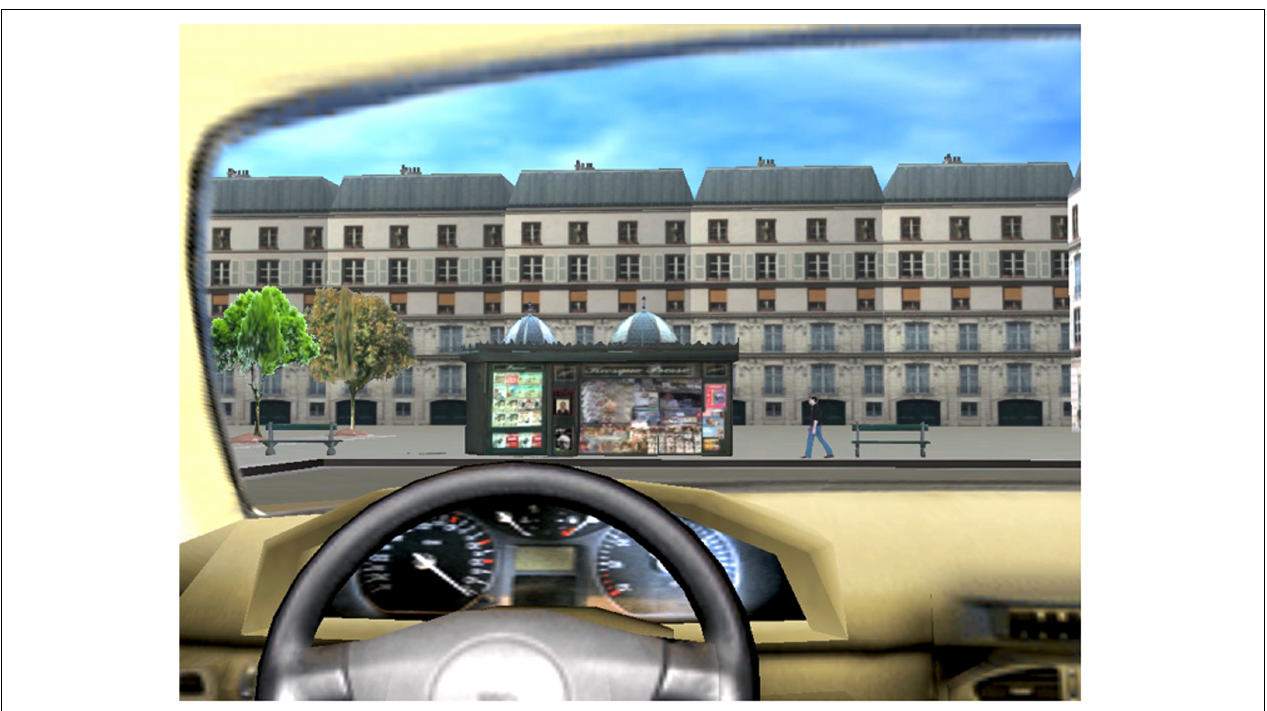
FIGURE 1 | Picture of a specific area of the virtual town (a newsstand, a man and two benches).